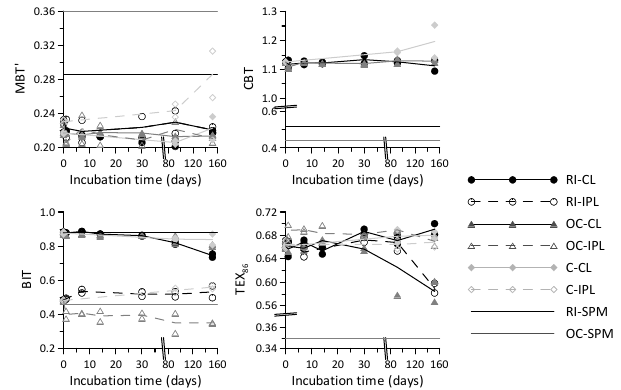
Figure 6. Distribution of core lipid (CL) and intact polar lipid (IPL)- derived GDGTs in a sandy loam soil from the Rakaia River catch- ment, New Zealand, as reflected by the (a) MBT (cid:48) index, (b) CBT in- dex, (c) BIT index, and (d) TEX 86 index during incubation ( t = 152 days) in river (RI), ocean (OC), and distilled (C) water under quasi- aerobic conditions. Horizontal straight lines represent GDGT com- position in river (black) and ocean water (grey) suspended particu- late material (SPM). Average concentrations are indicated by solid (CLs) and dashed (IPL-derived)